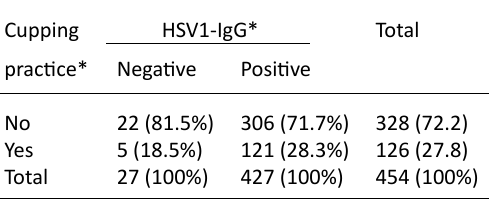
Table 5. HSV-1 Seroprevalences in Iraqi healthy blood donors, grouped according to cupping